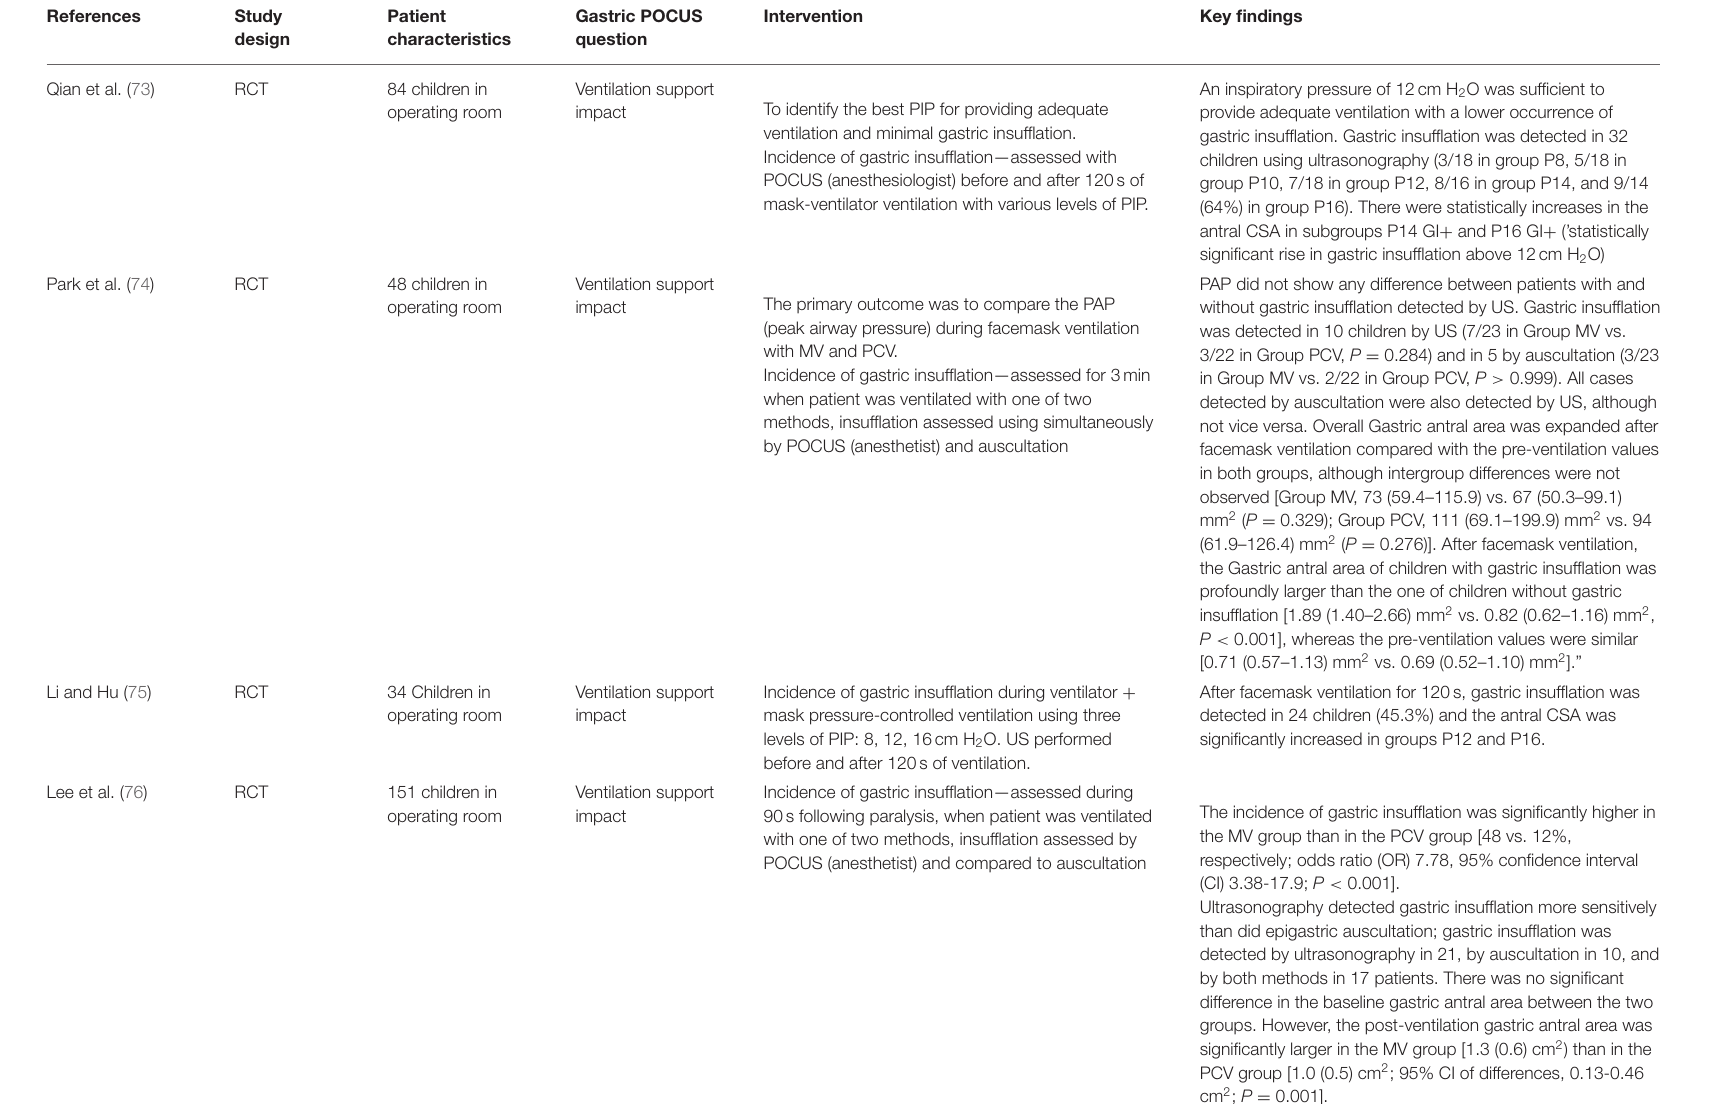
TABLE 5 | Study characteristics and findings: gastric insufflation/mechanical